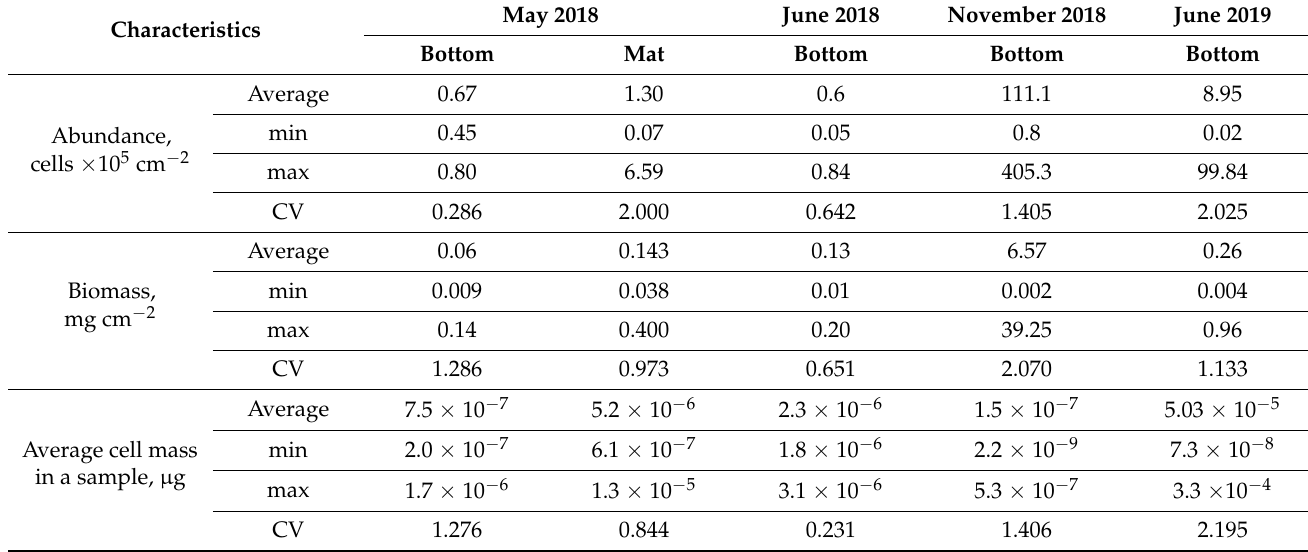
Table 4. Quantitative characteristics of microphytobenthos in Bay Sivash (2018–2019).